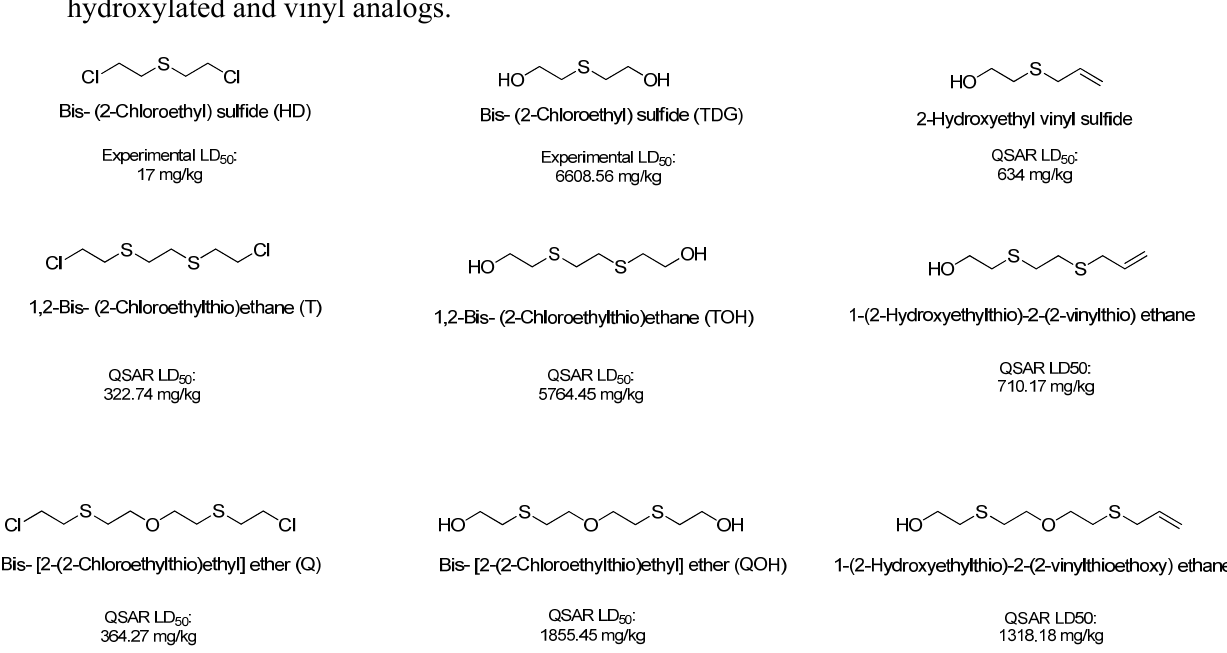
Figure 5. Sulfur mustard (HD), O-mustard (T) and sesquimustard (Q), and their hydroxylated and vinyl